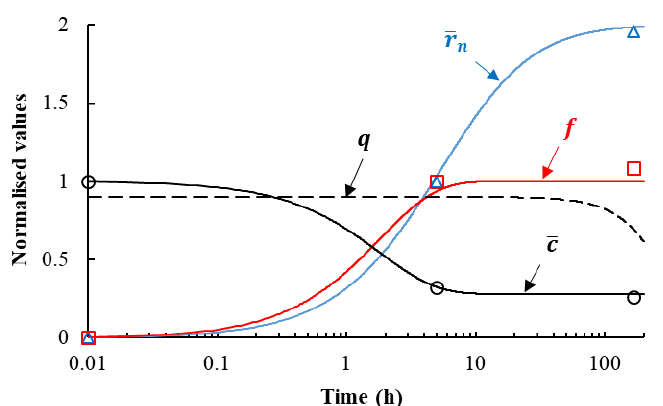
Figure 2. Comparison of evolutions of indicated microstructural variables during artificial ageing of AA6063 at 185 °C from experiments (symbols [33]) and modelling results from Table 1 (lines).